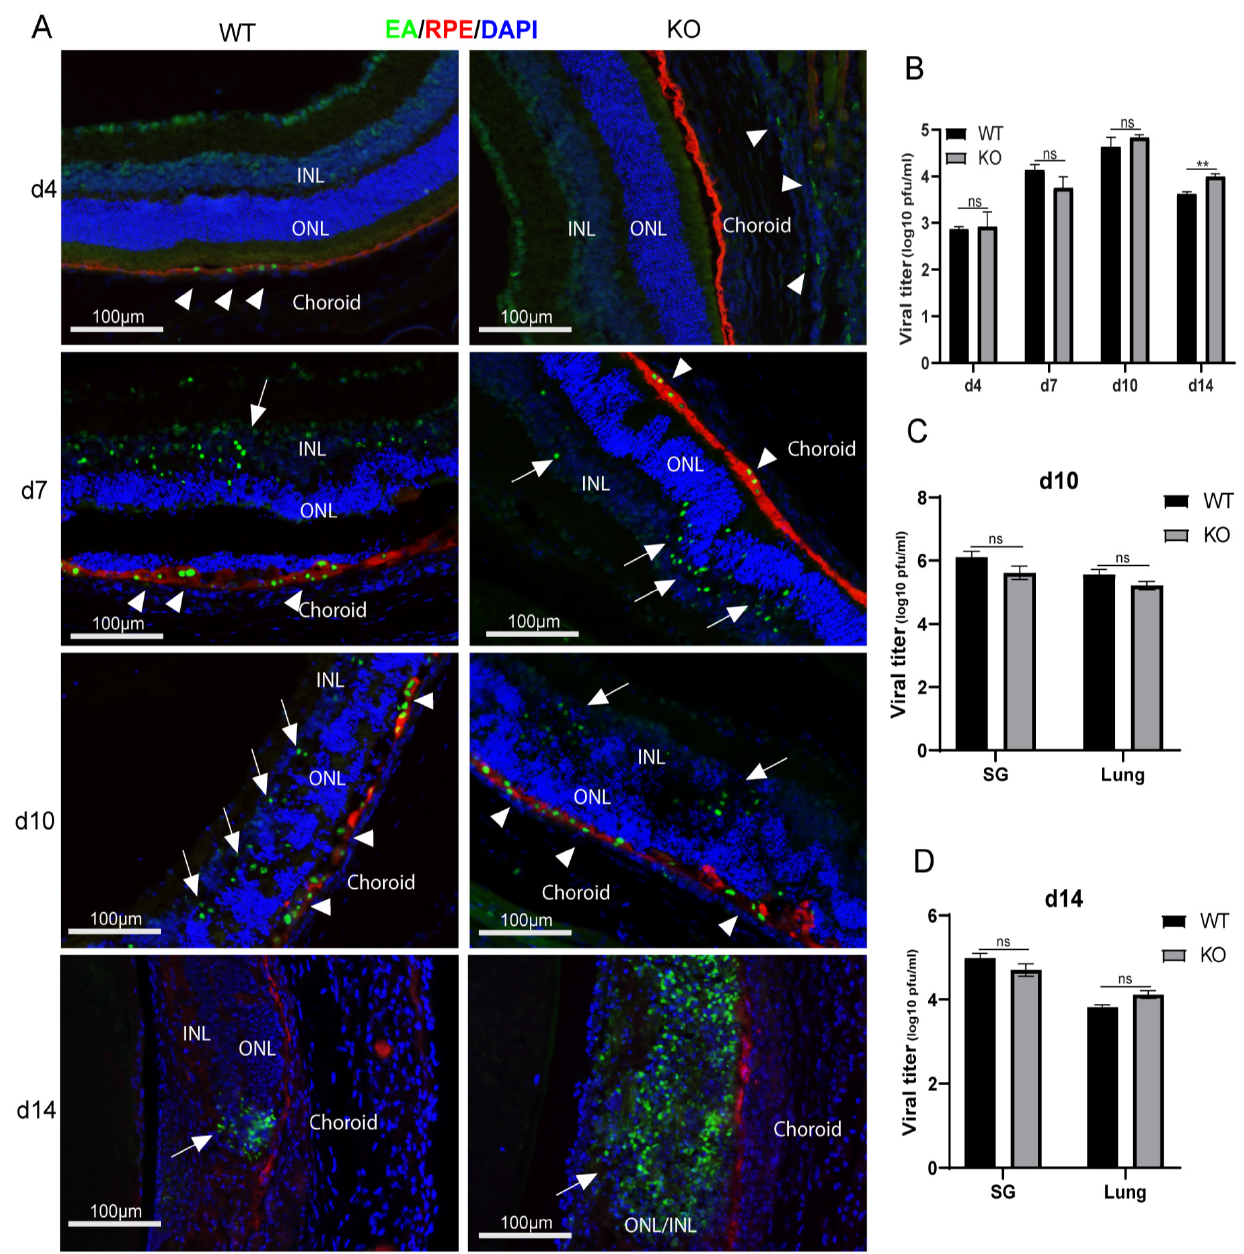
Figure 1. Caspase-12 deficiency promotes virus replication during MCMV retinitis. ( A ) Representative merged photomicrographs of staining for RPE65 (red), MCMV EA (green), and DAPI (blue) in MCMV-infected eyes of IS caspase-12 +/+ (WT) and caspase-12 − / − (KO) mice at day (d) 4, 7, 10, and 14 p.i. ( B ) Titer of MCMV (log10 ± SEM PFU/eye) in MCMV-injected eyes of WT and KO mice at day 4, 7, 10, and 14 p.i. ( C ) Titer of MCMV (log10 ± SEM PFU/eye) in retinas and non-retina remainders from MCMV-infected eyes of IS WT and KO mice at day 14 p.i. ( D ) Titers of MCMV (log10 ± SEM PFU/organ) in salivary glands and lungs of MCMV infected IS WT and KO mice at day 14 p.i. Data are shown as mean ± SEM ( n = 8). Statistical analysis by 2-tailed t-test. ** p < 0.01; ns means of no significance.